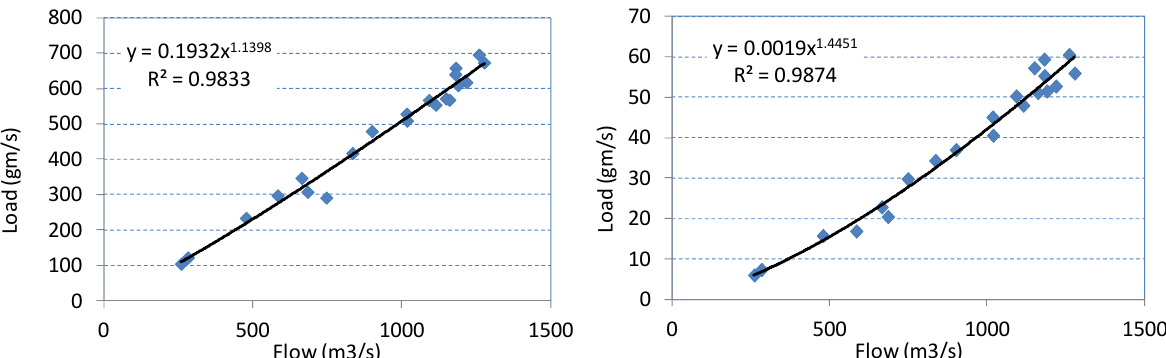
Figure 3. Correlation of NO 3 -N (left) and PO 4 -P (right) loadings with flow in the Saru River.